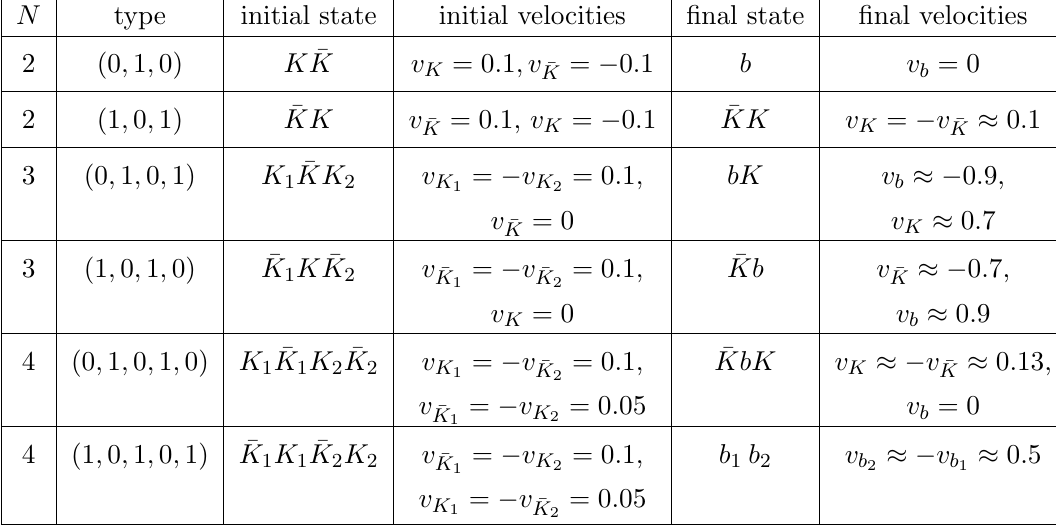
Table 1. Initial and (cid:12)nal velocities of